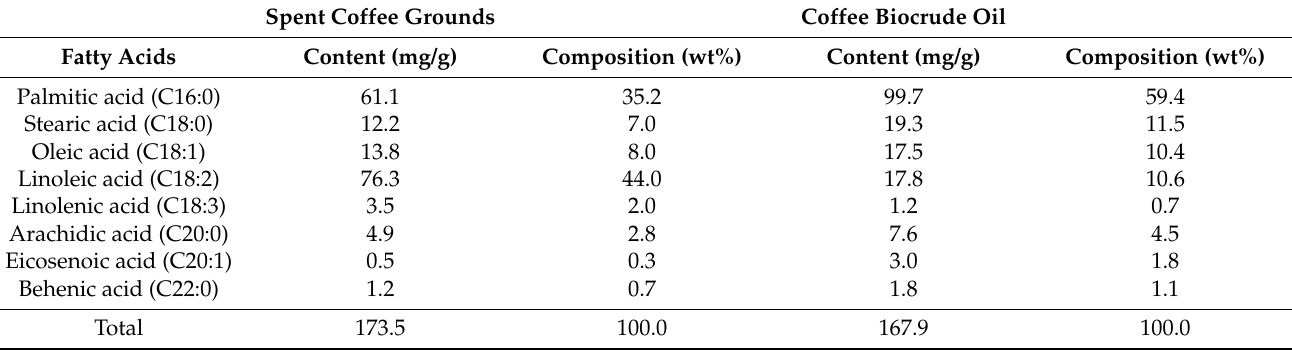
triglycerides and free fatty acids based on their dry weight. The palmitic acid (C16:0) composition was 35.2 wt% total fatty acids, and the linoleic acid (C18:2) composition was 44.0 wt% total fatty acids. Goh et al. [18] reported a lipid extraction yield from spent coffee grounds of 14.5 wt% based on ultrasonic extraction, and their two main fatty acids were palmitic acid (32.8 wt%) and linoleic acid (44.1 wt%). Somnuk et al. [24] obtained a 14.7 wt% lipid extraction yield from spent coffee grounds using hexane, and the contents of their palmitic and linoleic acids were 34.4 and 43.1 wt%, respectively. Table 1. Fatty acid contents and composition of spent coffee grounds and coffee biocrude oil by GC analysis.